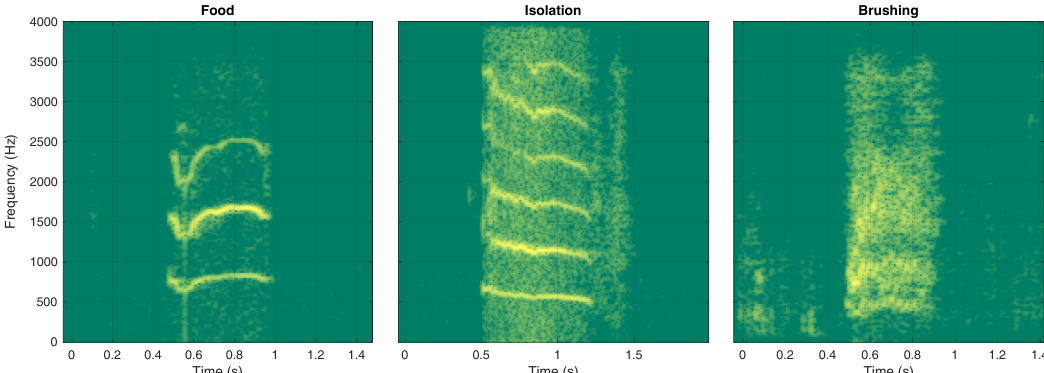
Figure 1. Time-frequency spectrograms of meows coming from the three considered